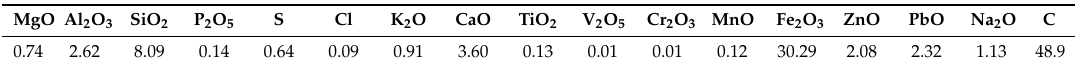
Table2. ED-XRFchemicalcompositionoftheblastfurnacesludgesusedasreducingagent(%byweight).